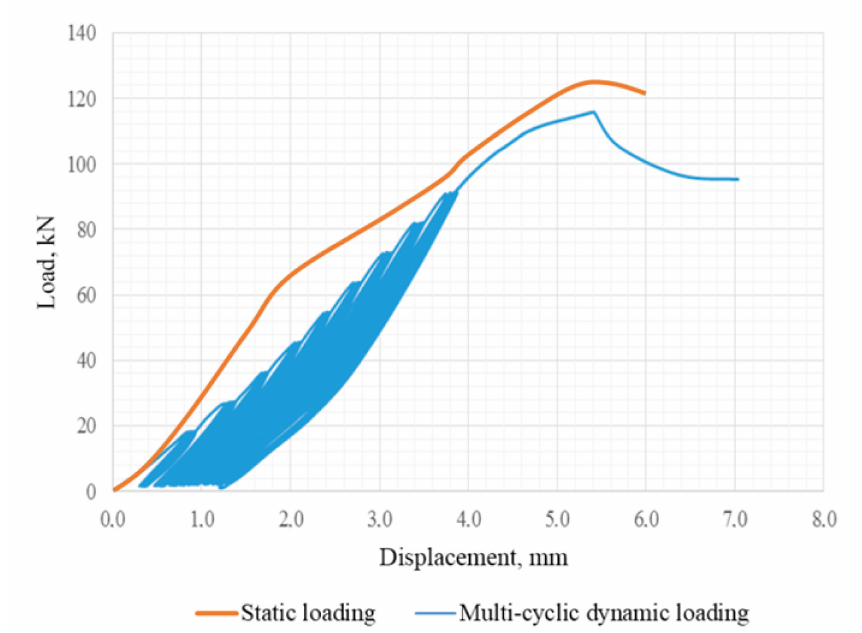
Figure 12. Characteristic load–displacement relationships in cases of static loading and multi-cyclic dynamic loading, if the anchorage fails due to the failure of the base concrete.